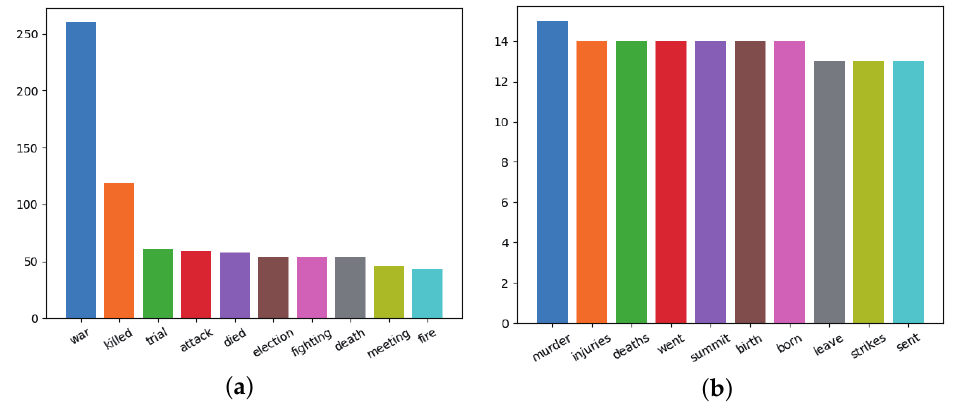
Figure 2. Statistics about the number of occurrences of triggers in the ACE2005 dataset. ( a ) Top 10 occurrences of triggers. ( b ) Top 50–60 occurrences of